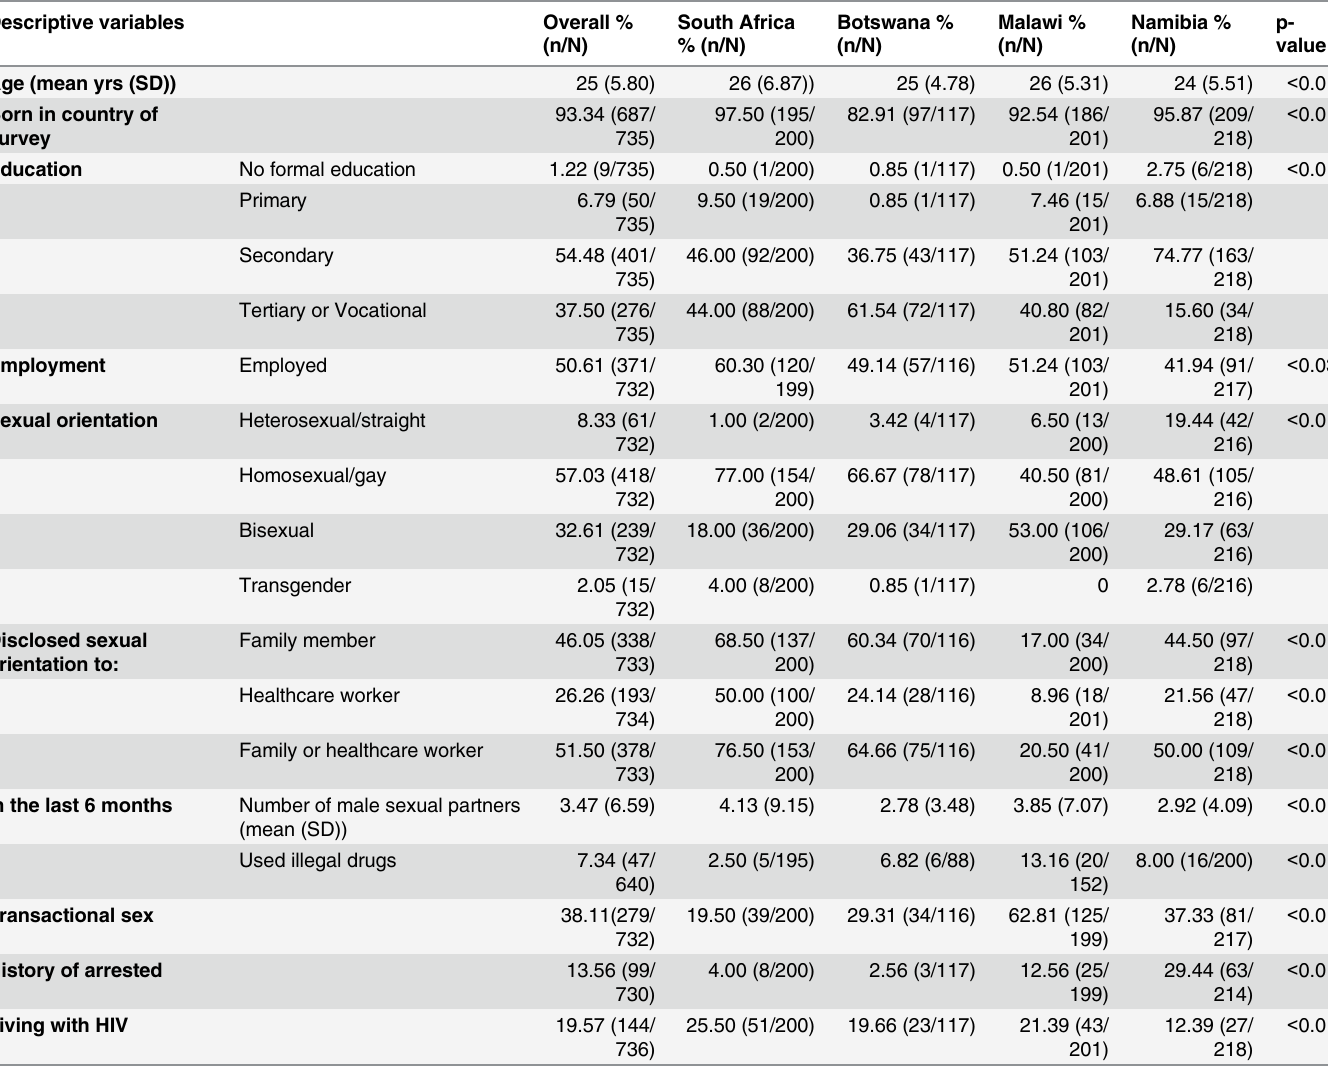
Table 1. Selected Characteristics of Sampled MSM Overall and by